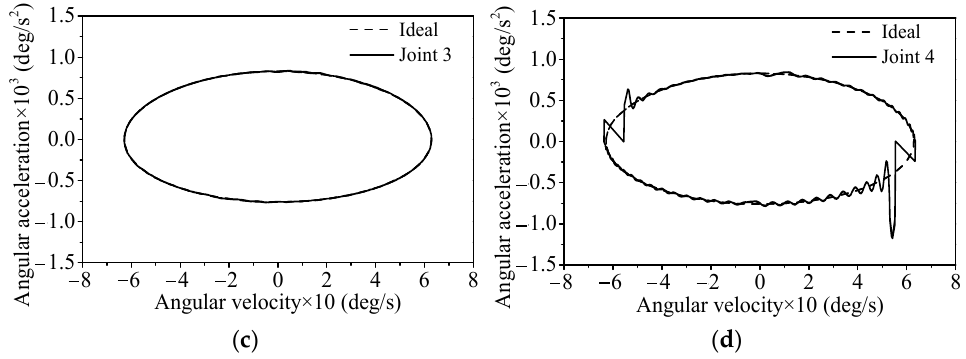
Figure 12. Angular acceleration-angular velocity phase diagram of the rigid system with different clearance joint position: ( a – d ) joints 1,2,3,4.